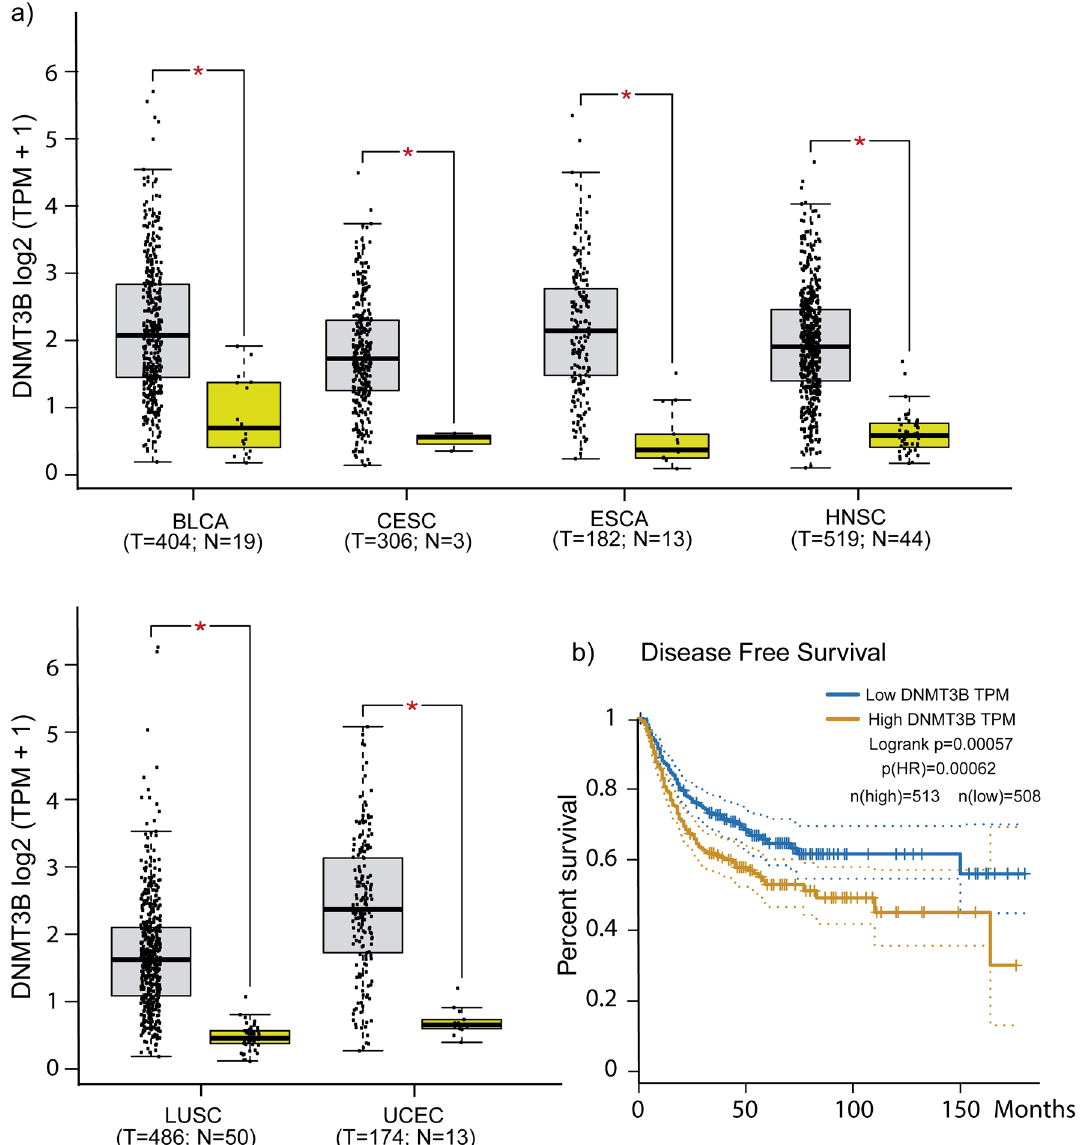
Figure 3. DNMT3B is overexpressed in tumors of patients from TCGA data sets and is correlated with poor prognosis. ( a ) Comparison of the DNMT3B expression in six epithelial carcinomas respect to normal tissue using data retrieved from TCGA. ( b ) Kaplan–Meier curves of disease-free survival for six solid tumors ( a ) with low versus high expression of DNMT3B. BLCA, Bladder Urothelial Carcinoma; CESC, Cervical Squamous Cell Carcinoma and Endocervical Adenocarcinoma; ESCA, Esophageal Carcinoma; HNSC, Head and Neck Squamous Carcinoma; LUSC, Lung Squamous Cell Carcinoma; UCEC, Uterine Corpus Endometrial Carcinoma; T, Tumor; N, Normal